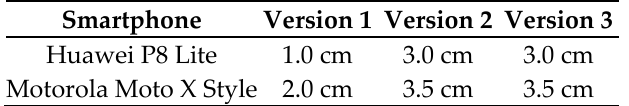
Table 1. Maximum Range. The ruler used for measure the distance has a resolution of 0.5 cm.